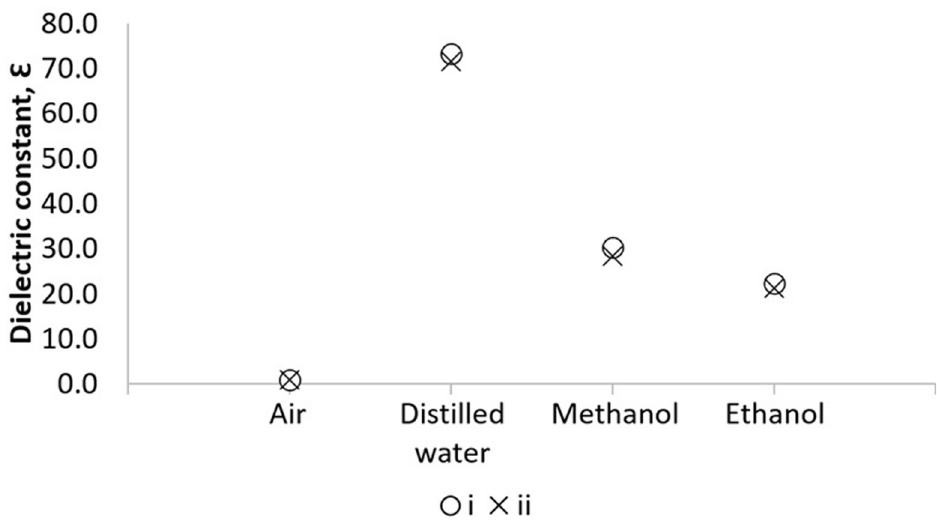
Fig 1. Comparison of calibration results using air, distilled water, methanol, and ethanol between the data from (i) this study and (ii) Dortmund Data Bank.